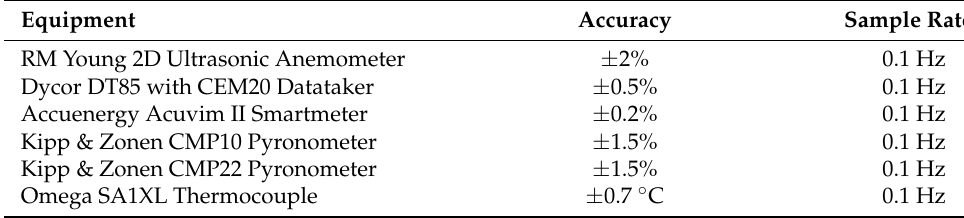
Table 3. Reported Equipment Error and Sampling